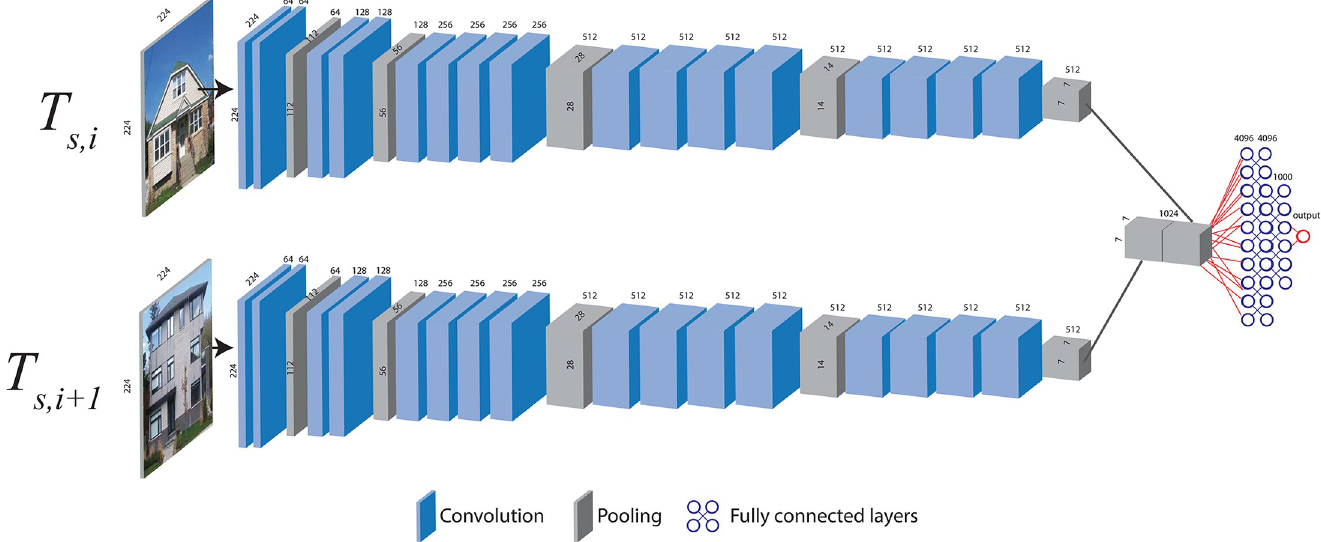
Fig 3. Siamese CNN architecture using two VGG19 branches. The top branch convolves the first image, T location s , ( T s = { T s , i : i 2 T s }, s = ( x , y )), and the bottom branch convolves the second image T s , i +1 in the sequence. The last pooling block in each branch are concatenated and flattened before being fed to a set of three fully connected layers to produce the output probability using a sigmoid activation. The numbers along the sides of each convolutional layer represent the tensor dimensions (columns and rows), and the numbers across the top of the layers represent the tensor filter block’s depth. Photos are the author’s and are presented for illustrative purposes.